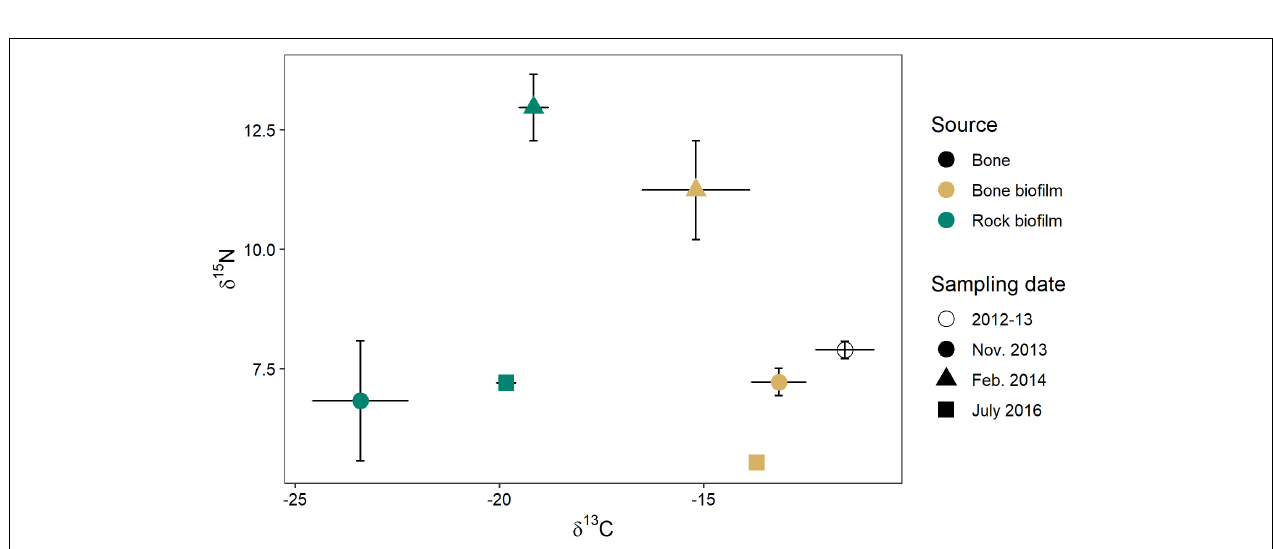
FIGURE 10 | C and N stable isotope signatures of wildebeest bone ( n = 8) and biofilm on rock and on bone on three sampling dates ( n = 3 of each at each time point) in the Mara River.